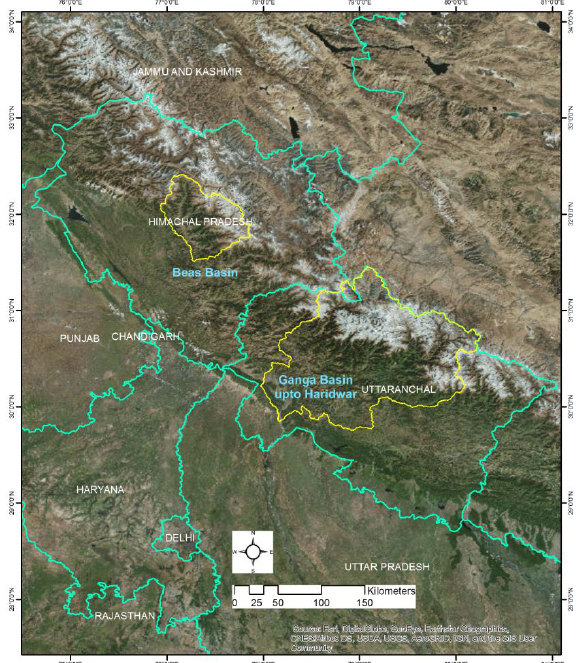
Figure 1: Selected rivers basins (Beas and Upper Ganga) for SAR based snow cover study.